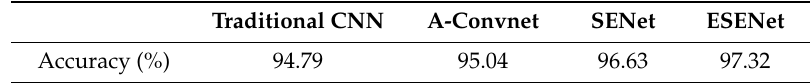
Table 5. Recognition accuracy comparison under SOC.